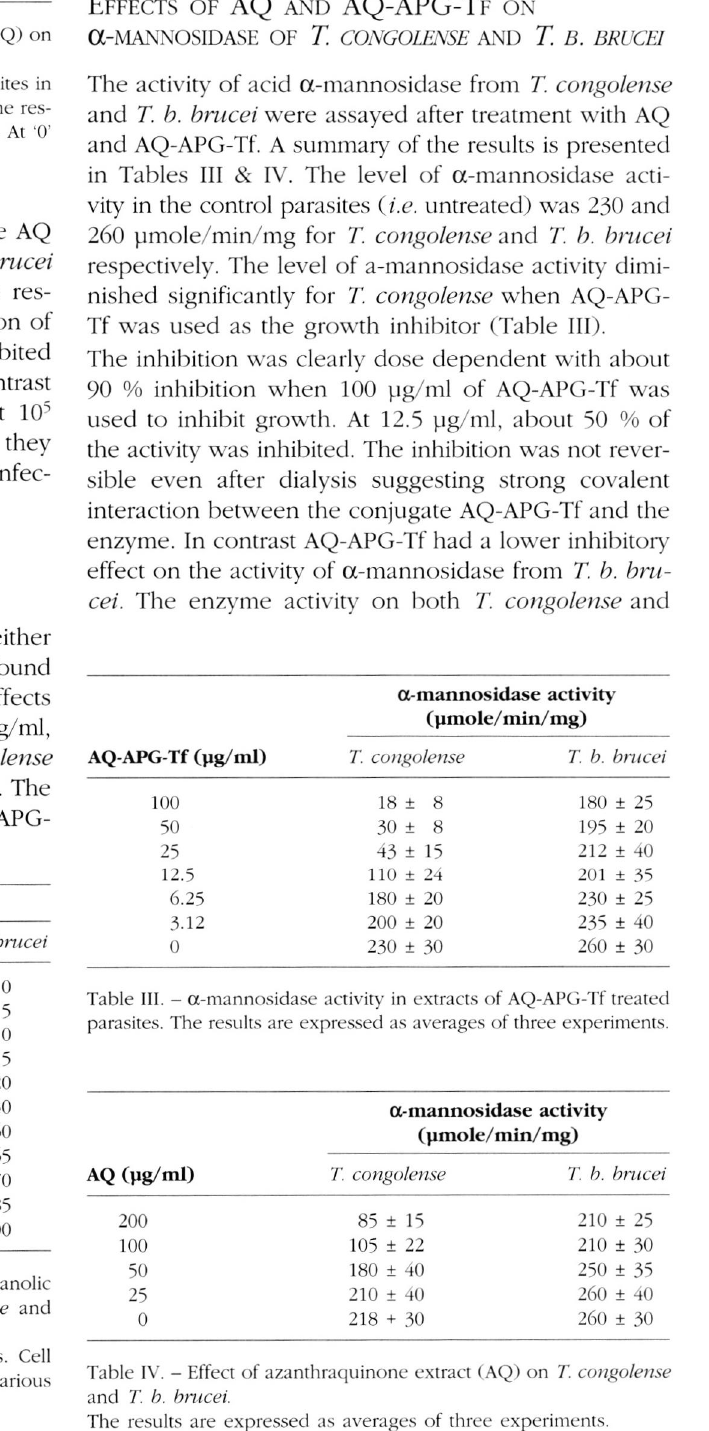
Table IV. - Effect of azanthraquinone extract (AQ) on T. congolense and T. b. brucei. The results are expressed as averages of three experiments.